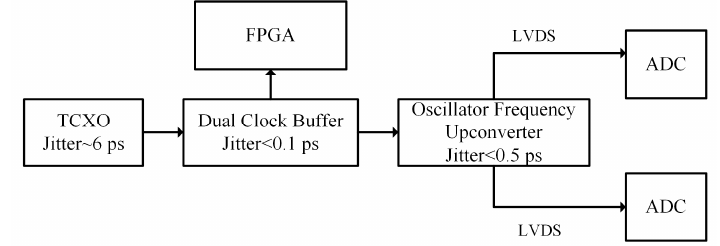
Figure 8. Modified clock link.